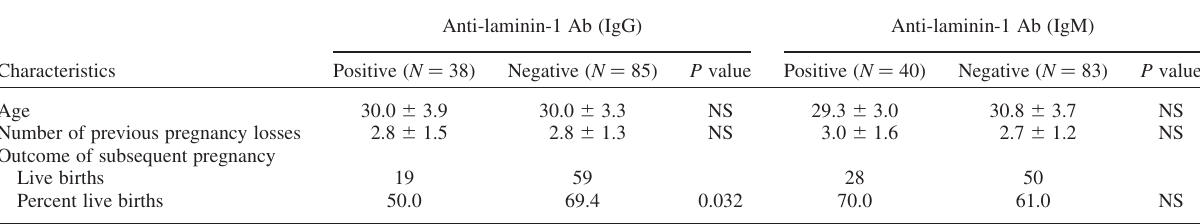
TABLE I Relationship between the prevalence of anti-laminin-1 autoantibodies and subsequent pregnancy outcome in recurrent spontaneous